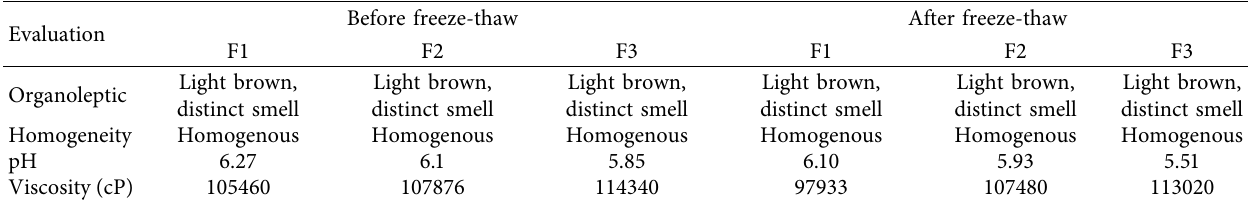
Table 4: Stability test